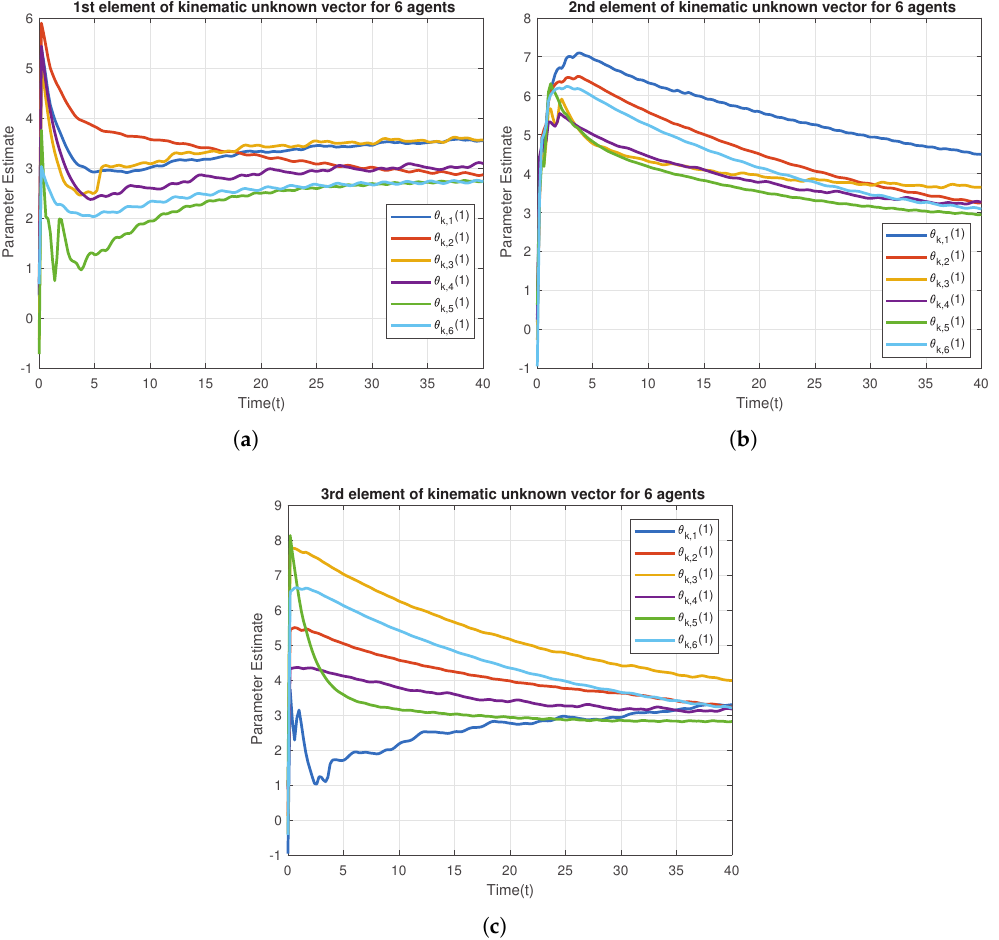
Figure 6. Kinematic parameter estimates θ k , i of the Euler-Lagrange agents. ( a ) 1st element; ( b ) 2nd element; ( c ) 3rd